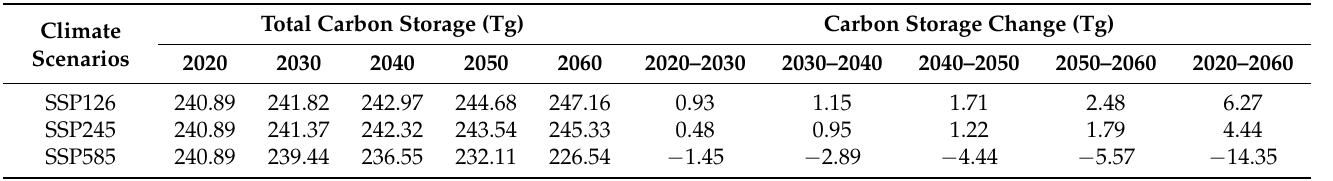
Figure 7. Distribution changes of carbon storage under each scenario compared to 2020. Table 4. Carbon storage dynamic changes in terrestrial ecosystems under different scenarios during the period of